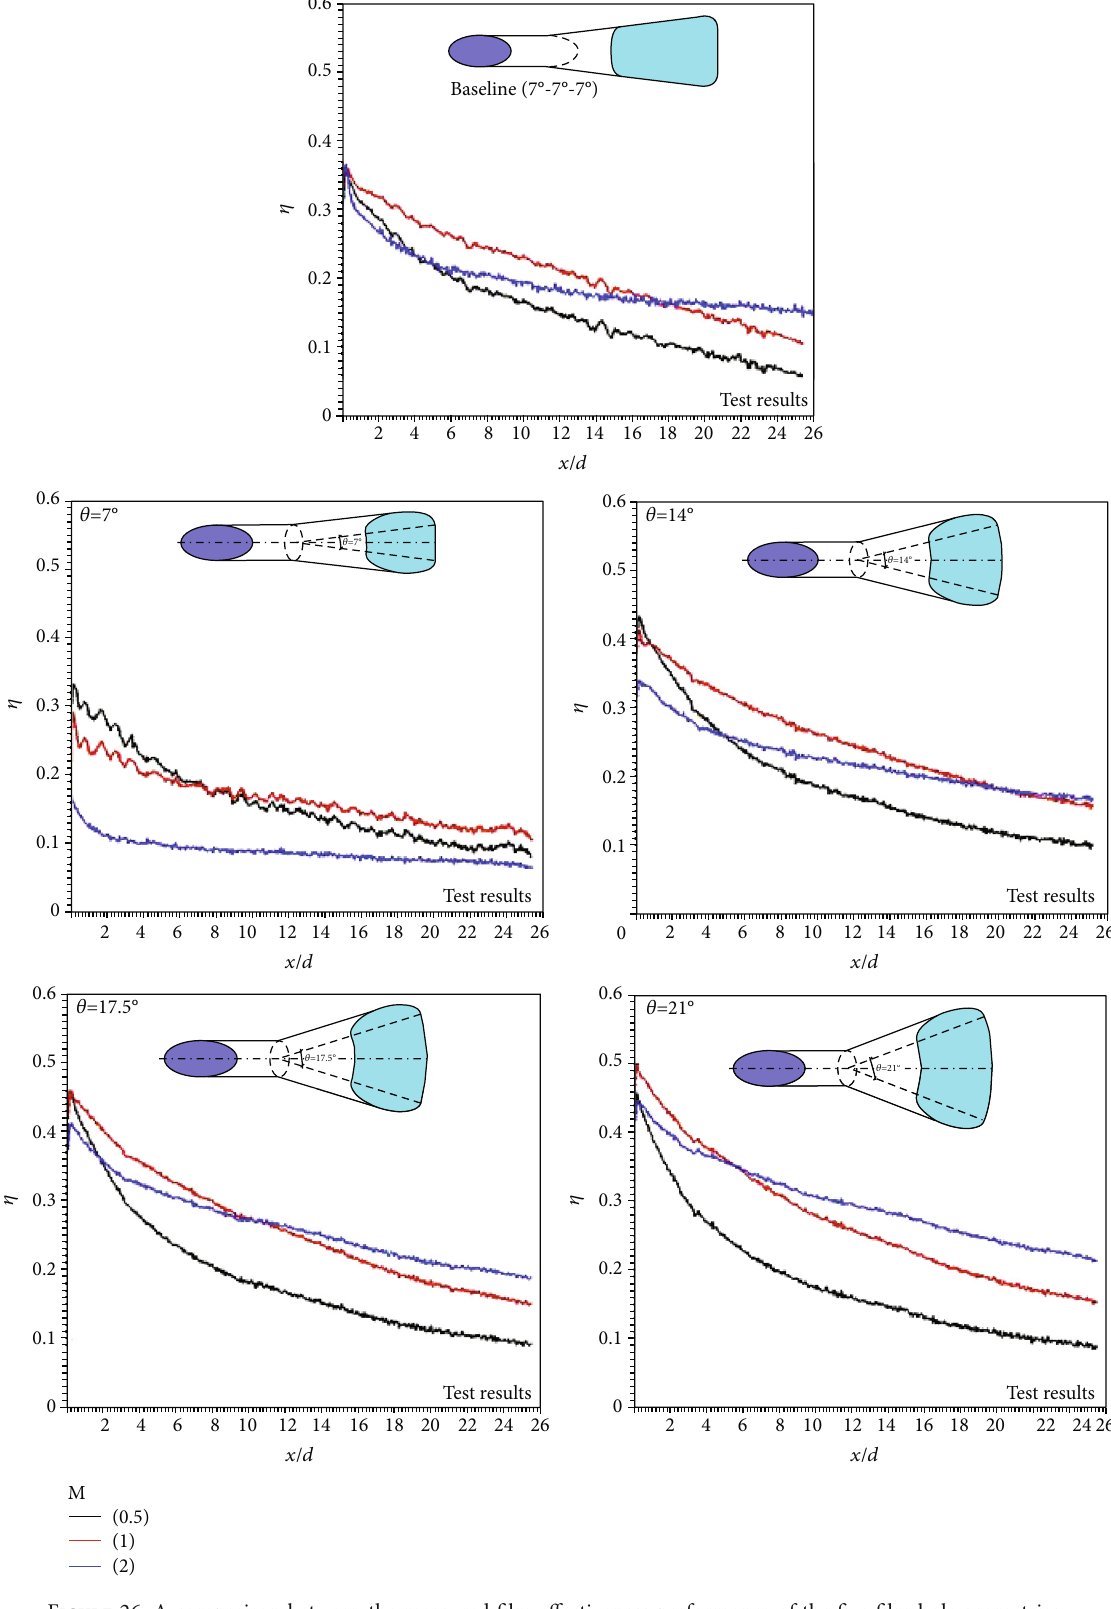
Figure 26: A comparison between the measured fi lm e ff ectiveness performance of the fi ve fi lm hole